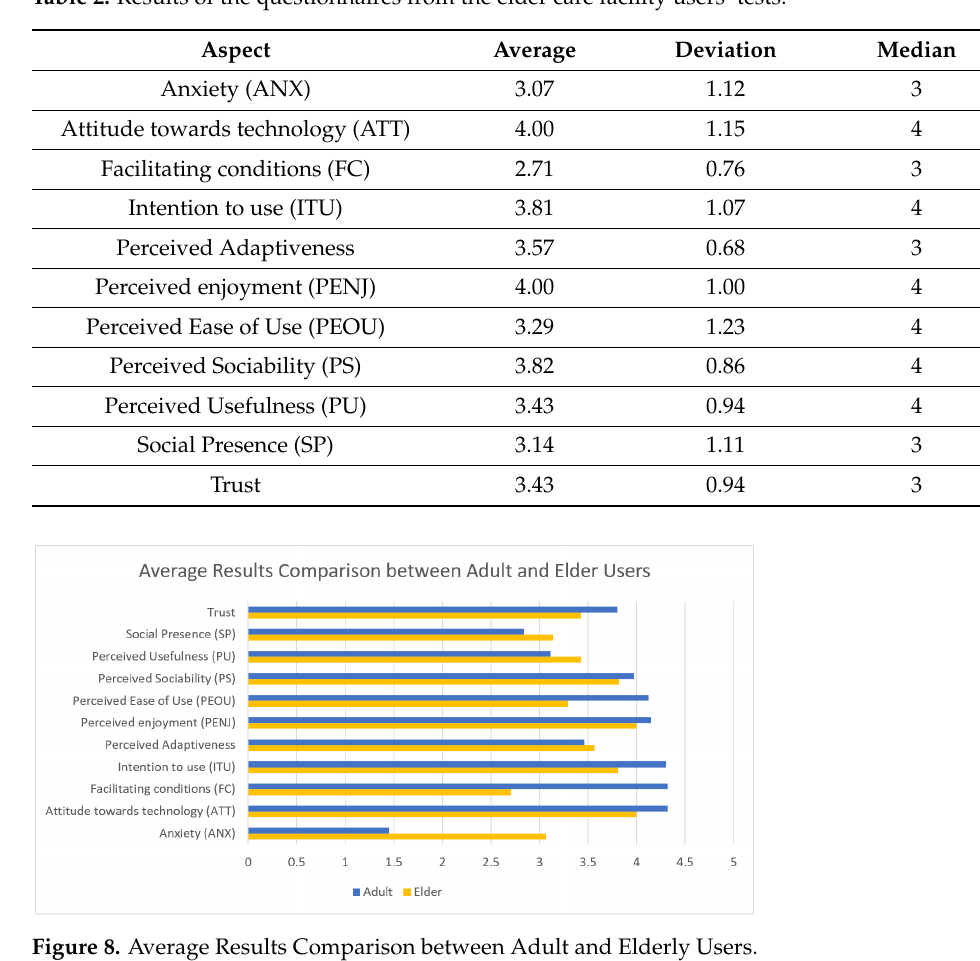
Table 2. Results of the questionnaires from the elder care facility users’ tests.